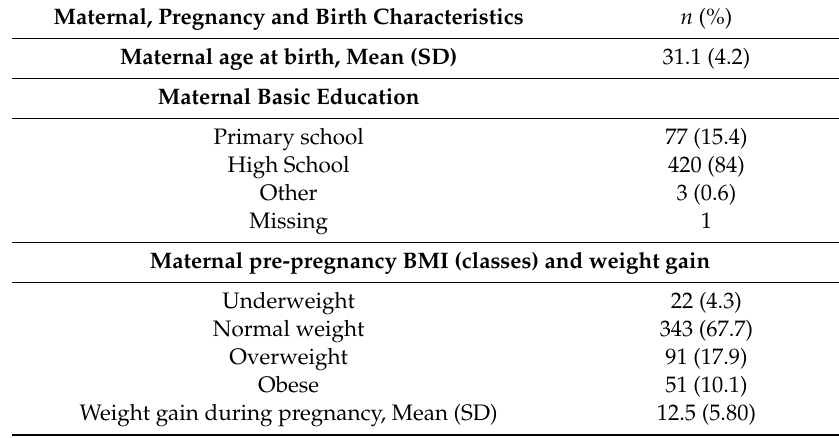
Table 1. Overall characteristics of the study population for n = 501 mothers and n = 507 infants taking part in the Finnish STEPS